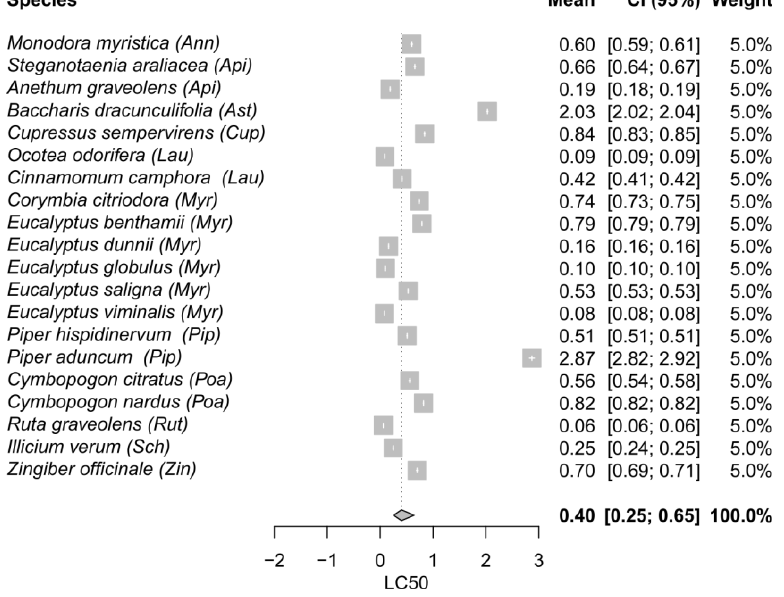
Figure 3. Meta-analysis on the contact toxicity of EOs against S. zeamais through filter paper impregnation. Single LC 50 means and the LC 50 global mean are represented along with their corresponding 95% confidence intervals. The abbreviations are as follows: Annonaceae (Ann), Apiaceae (Api), Asteraceae (Ast), Cupressaceae (Cup), Lauraceae (Lau), Myrtaceae (Myr), Piperaceae (Pip), Poaceae (Poa), Rutaceae (Rut), Schisandraceae (Sch), Zingiberaceae (Zin).